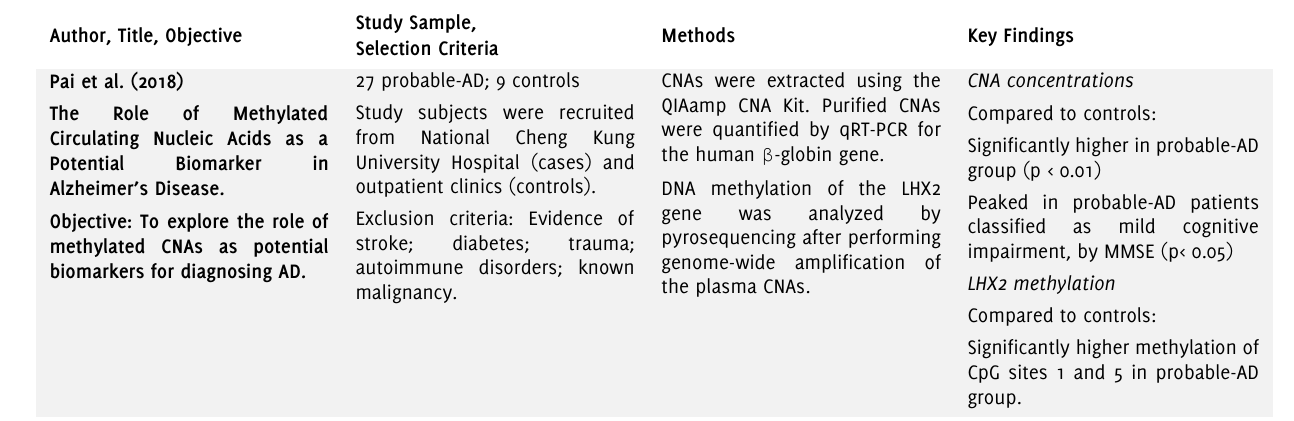
Table 4. Circulating Nucleic Acids as biomarkers for Alzheimer’s disease.